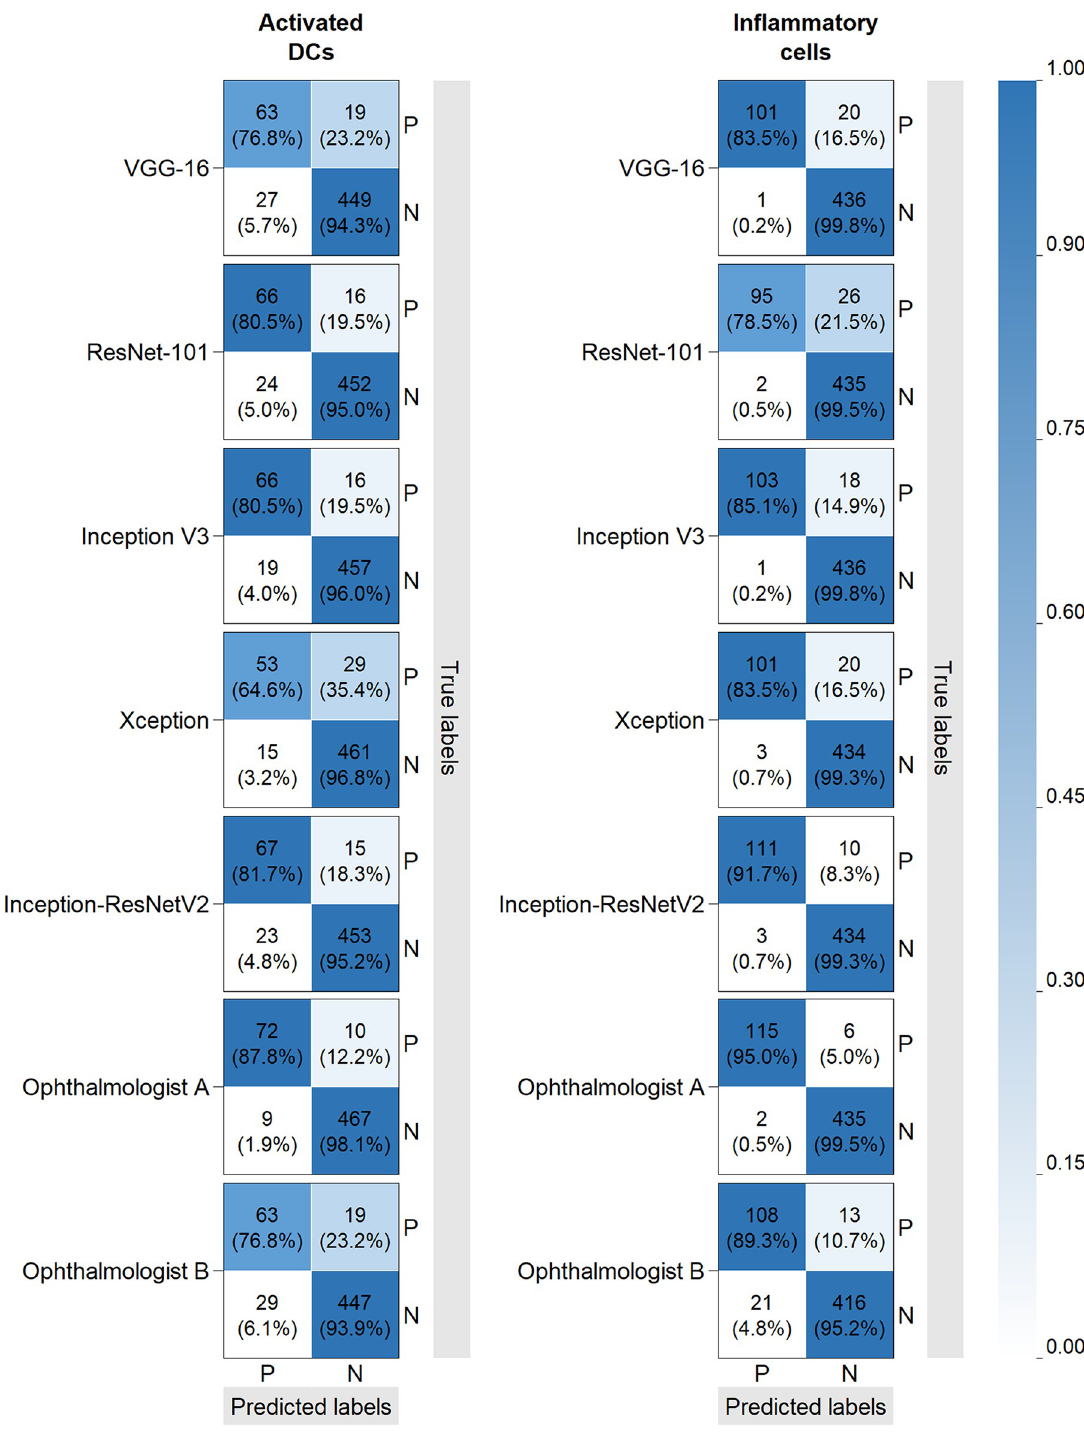
Fig 5. Confusion matrices of external validation in detecting activated dendritic cells (DCs) and inflammatory cells. DCs, dendritic cells; P: Positive; N: Negative. Confusion matrices of deep transfer learning models and ophthalmologists in detecting activated dendritic cells (DCs) and inflammatory cells are shown. True positive, true negative, false positive and false negative rates are calculated. Matrix cells are colored according to the rates.